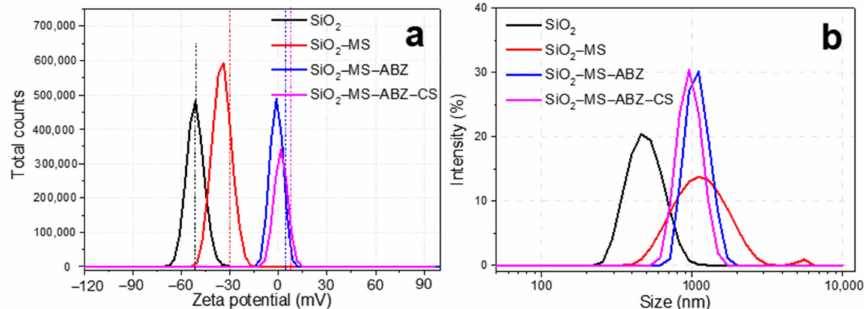
Figure 5. Analysis of ( a ) zeta potential and ( b ) hydrodynamic diameter of the silica-based particles.